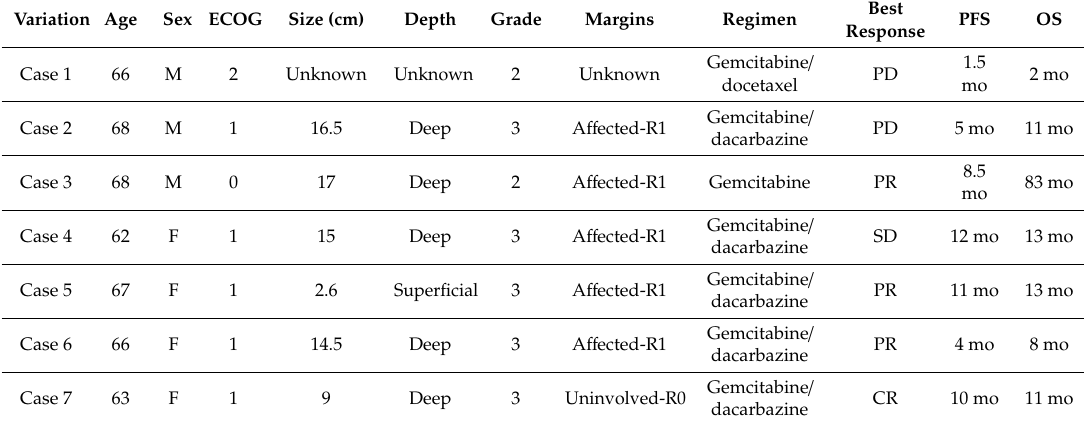
Table 1. Baseline